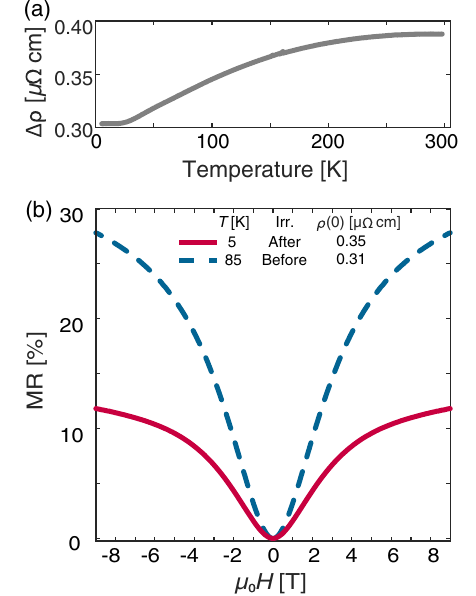
FIG. 14. (a) The difference of the temperature-dependent resistivity after and before the irradiation. (b) The magnetoresist- ance [MR ¼ ½ ρ ð H Þ − ρ ð 0 Þ(cid:2) = ρ ð 0 Þ ] measured at 5 K after irradi- ation compared to that measured at 85 K before irradiation (dashed line). The zero field resistivity (legend) was the same within 10% in the two